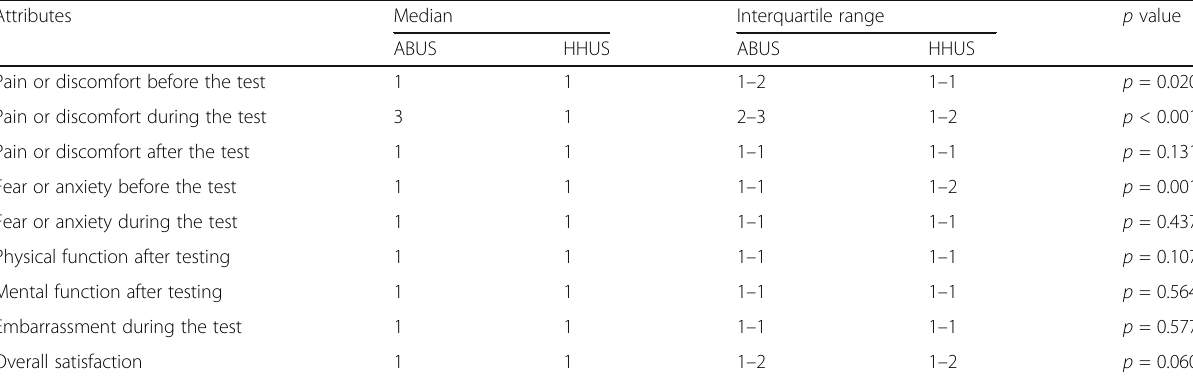
Table 2 Median values and interquartile range for the attributes evaluated